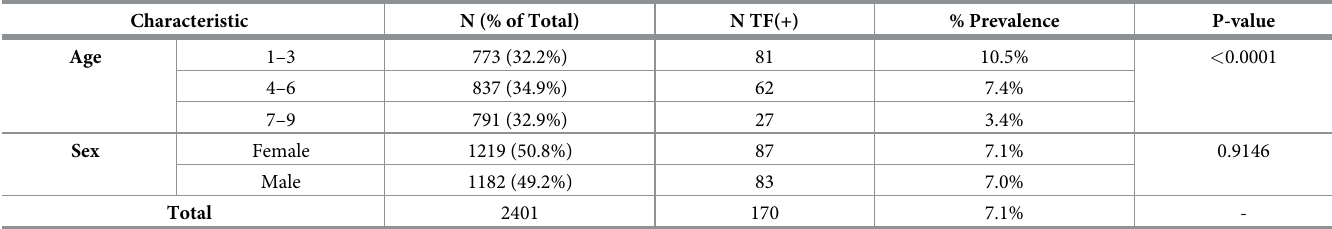
Table 1. Prevalence of field grade of trachoma by the characteristics of the sample of children ages 1–9 years in Kongwa District, Tanzania. Characteristic